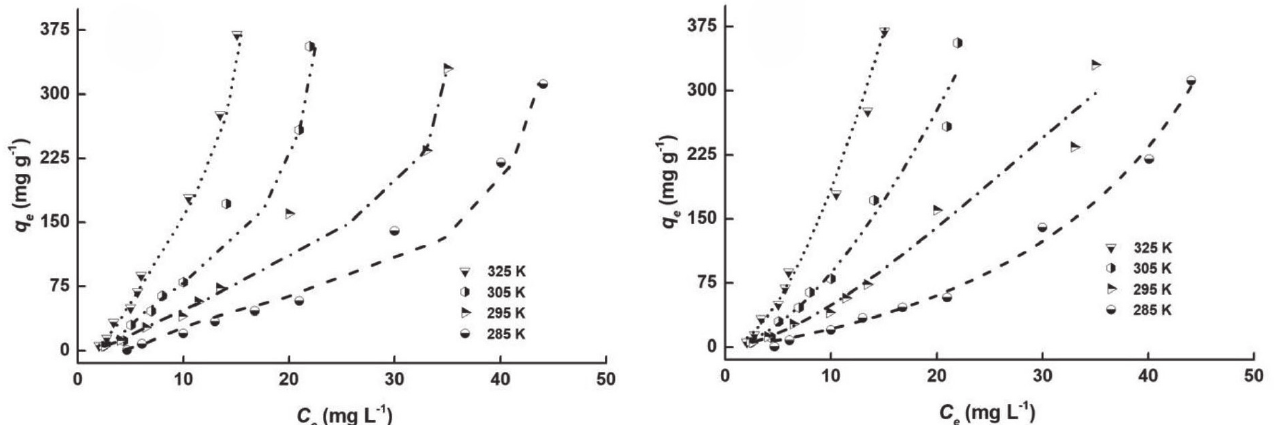
Fig. 7 – (a) Experimental adsorption isotherms of humic acid adsorption onto Co-MOF (pH = 6, adsorbent dosage = 25 mg, vol- ume = 0.05 L, HA initial concentration = 5–200 mg L –1 , temperature = 285–325 K) (b) Comparison of experimental data with KC modeled